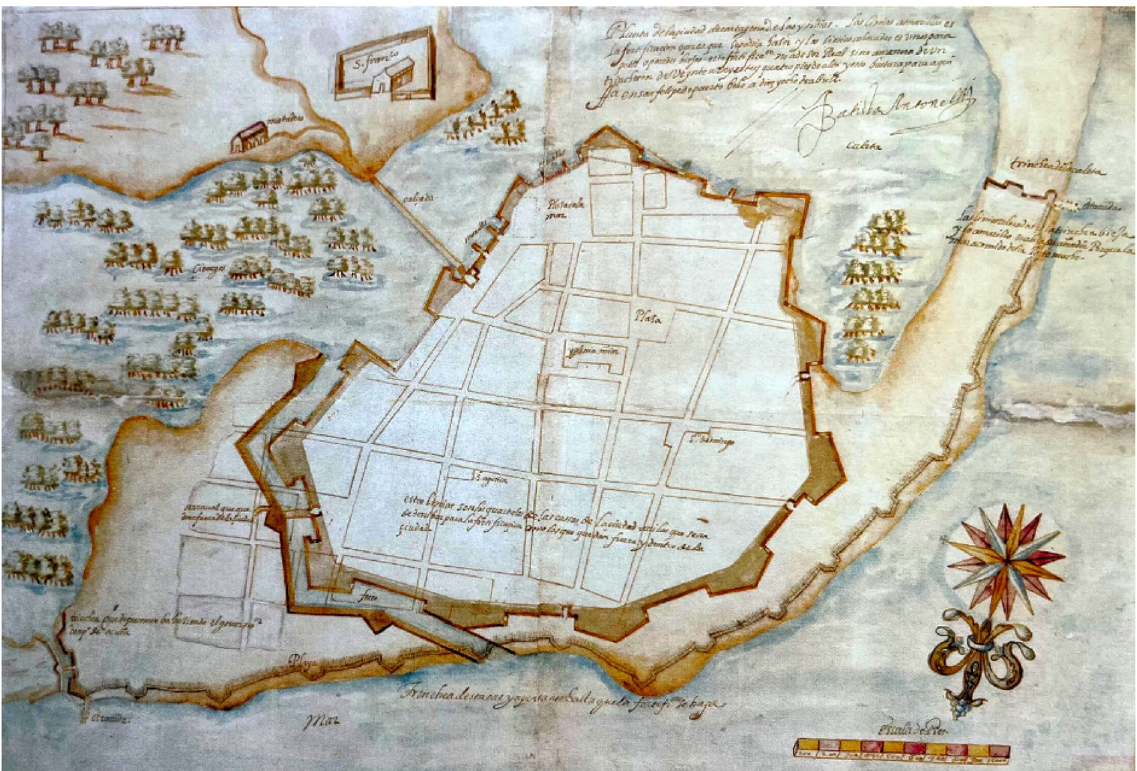
Fig. 8 Original drawings of Battista Antonelli, from 1594 Plan of the City of Cartagena de Indias and its fortifications, showing by yellow lines the fortification or nearby that could be done. Taken and adapted form (Portal de Archivos Españoles (PARES)